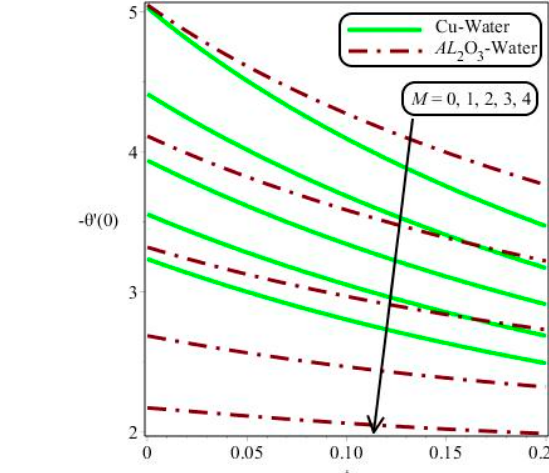
Figure 10. ( a , b ) Impact of M on local skin friction with K 1 = 0.7, β = 0.7, and γ = π /4.